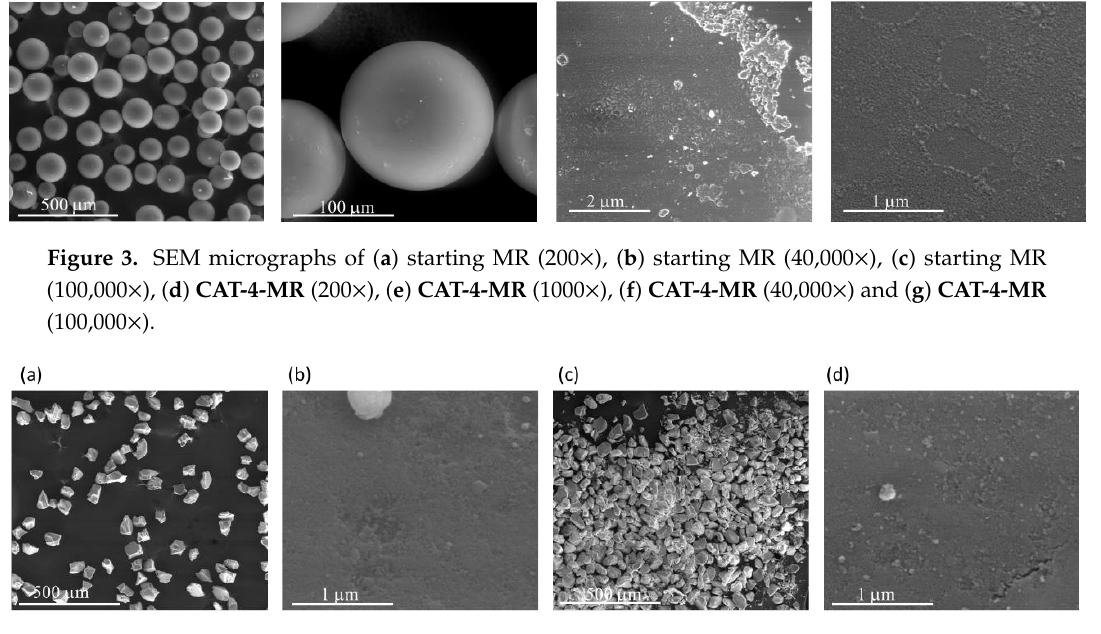
Figure 4. SEM micrographs of ( a ) starting silica (200×), ( b ) starting silica (100,000×), ( c ) CAT-4-Si (200×) and ( d ) CAT-4-Si (100,000×). Table 1. Surface atomic percentages for CAT-4-Si , CAT-4-MR and CAT-5-MR obtained by XPS 1 .